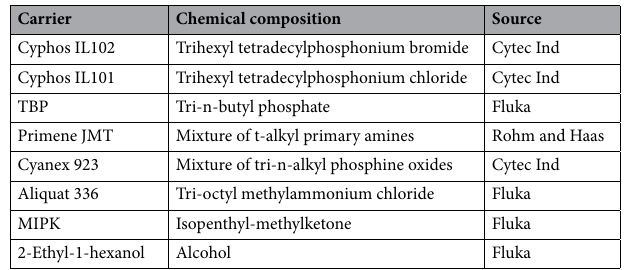
Table 4. Chemical compositions and sources of the